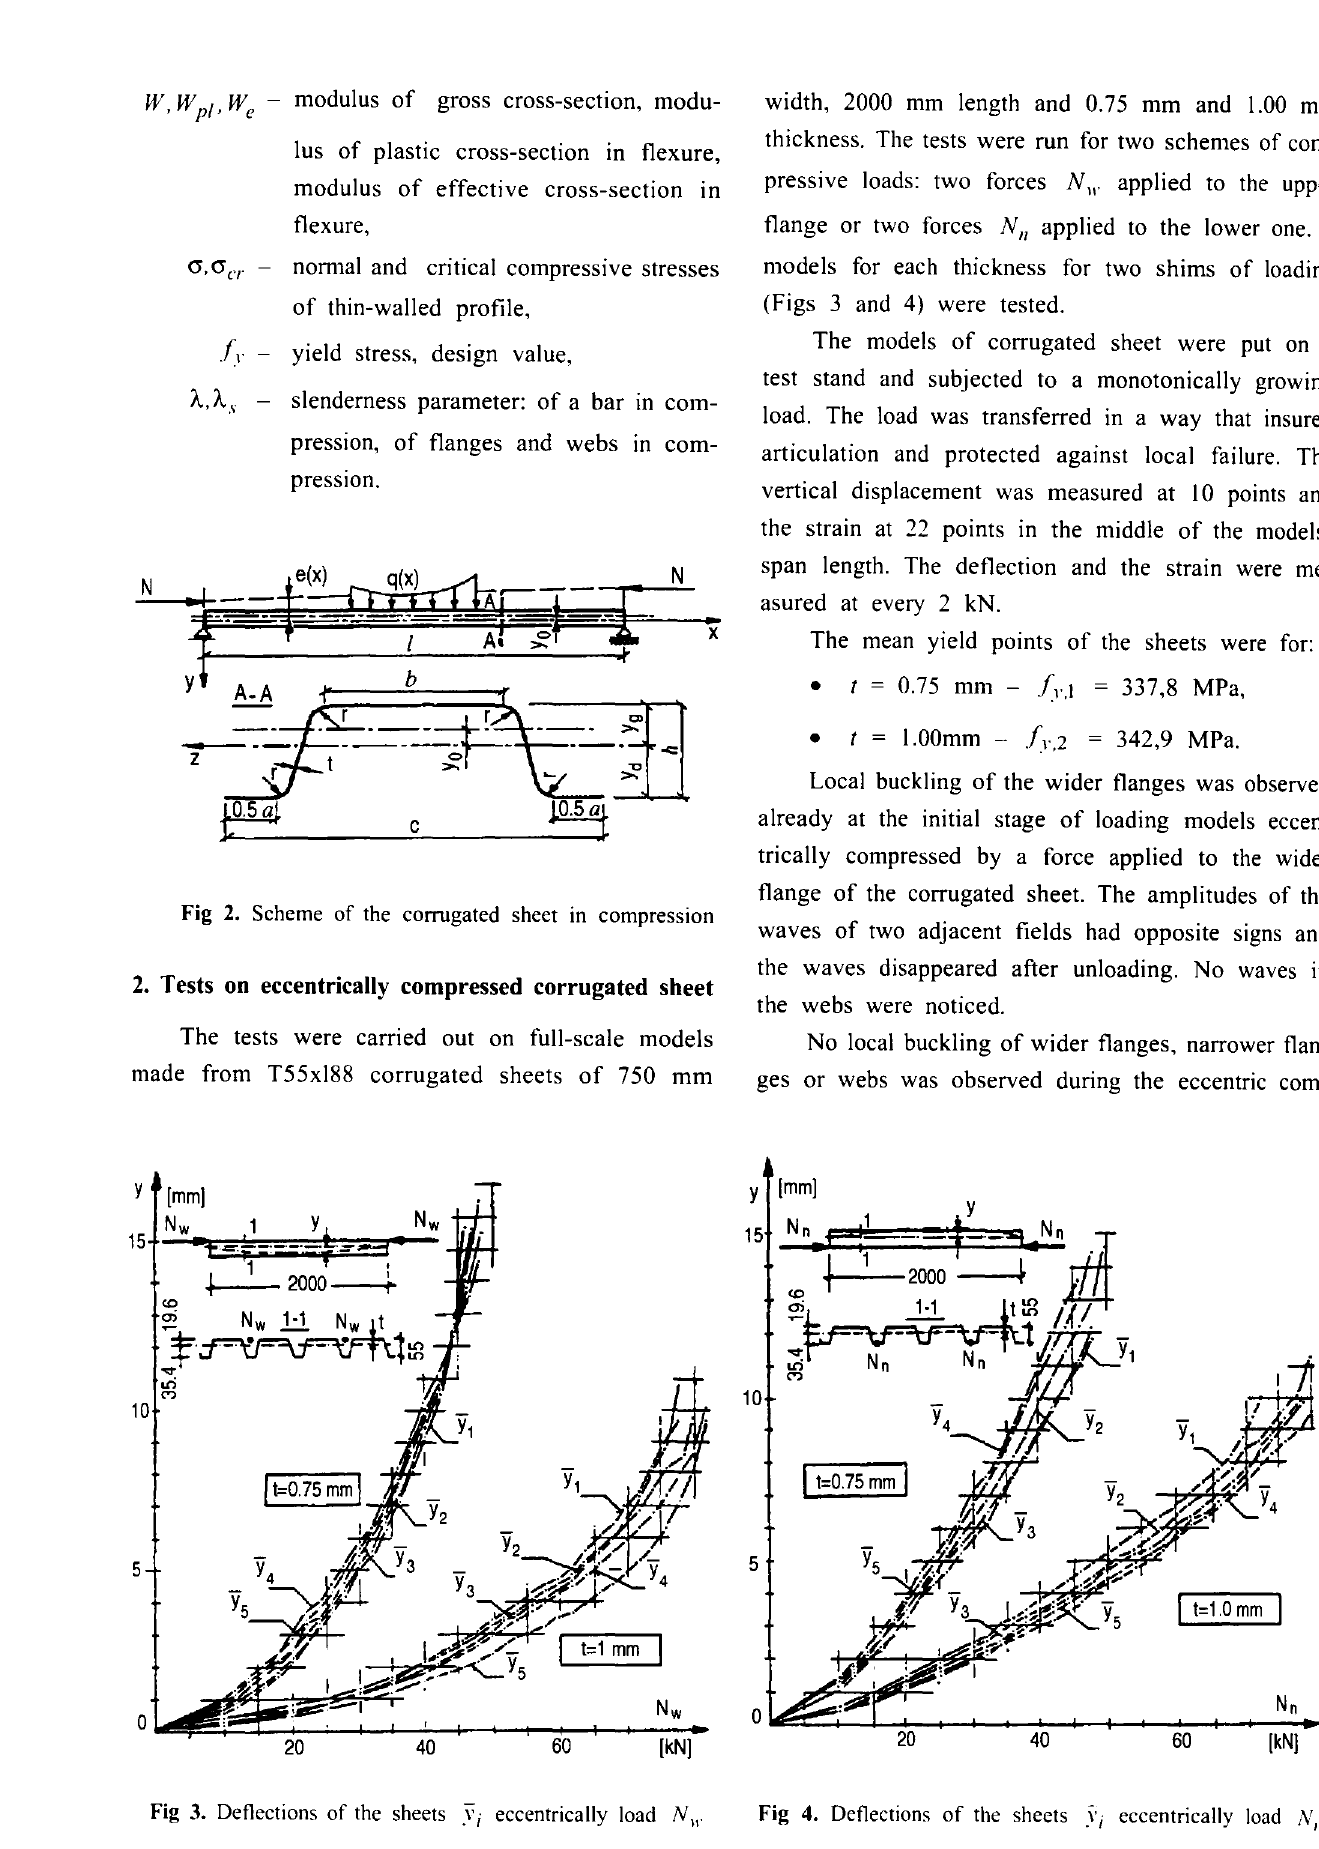
Fig 2. Scheme of the corrugated sheet in compression